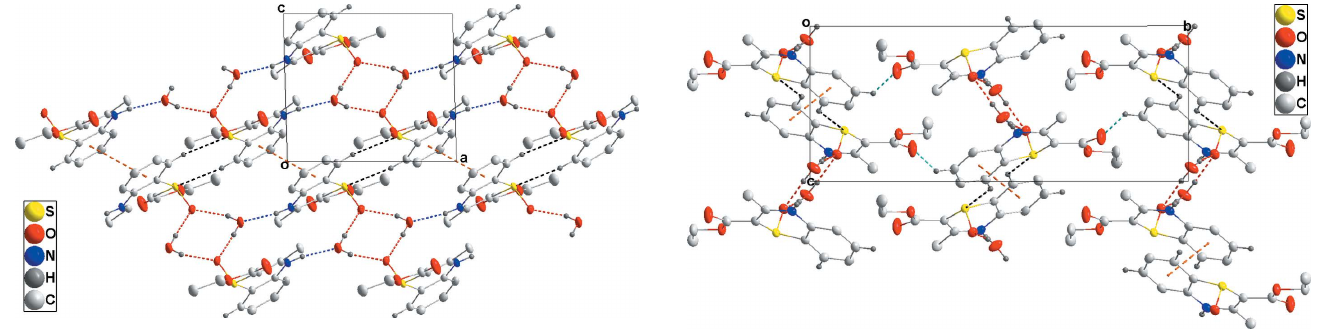
Figure 3 Packing viewed along the a -axis direction with intermolecular inter- actions depicted as in Fig. 2 with the addition of light-blue dashed lines for the C—H (cid:2)(cid:2)(cid:2) O hydrogen bonds.